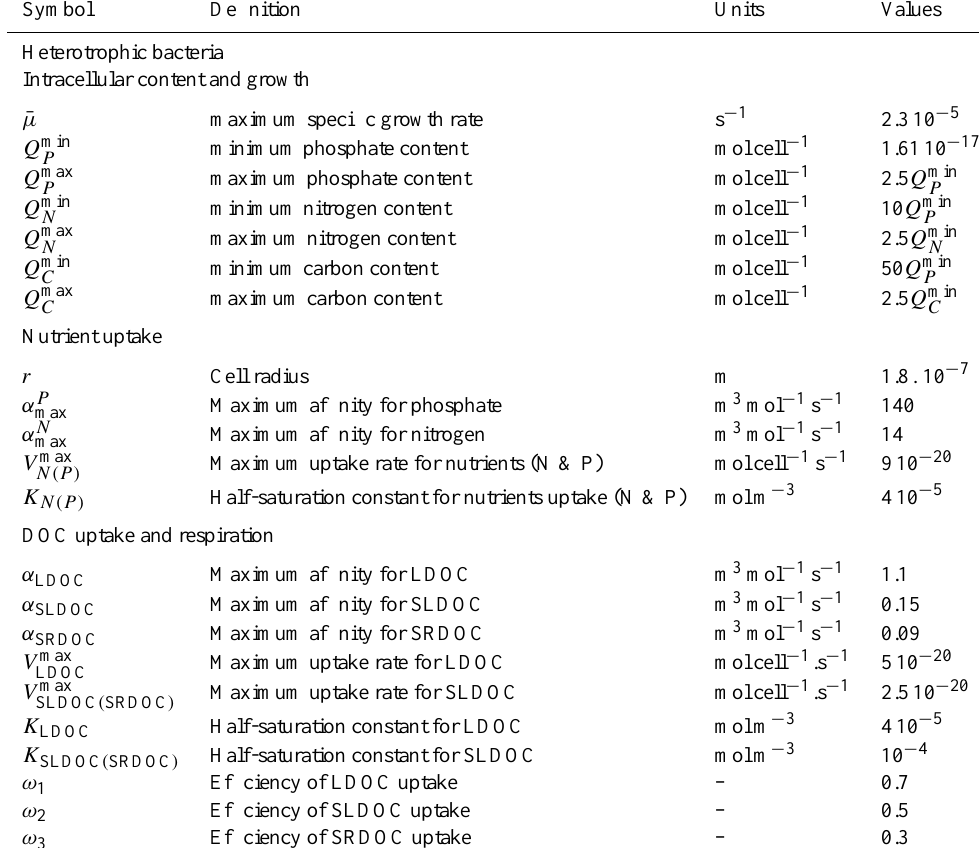
Table 5. Model’s parameters for heterotrophic bacteria. Symbol Definition